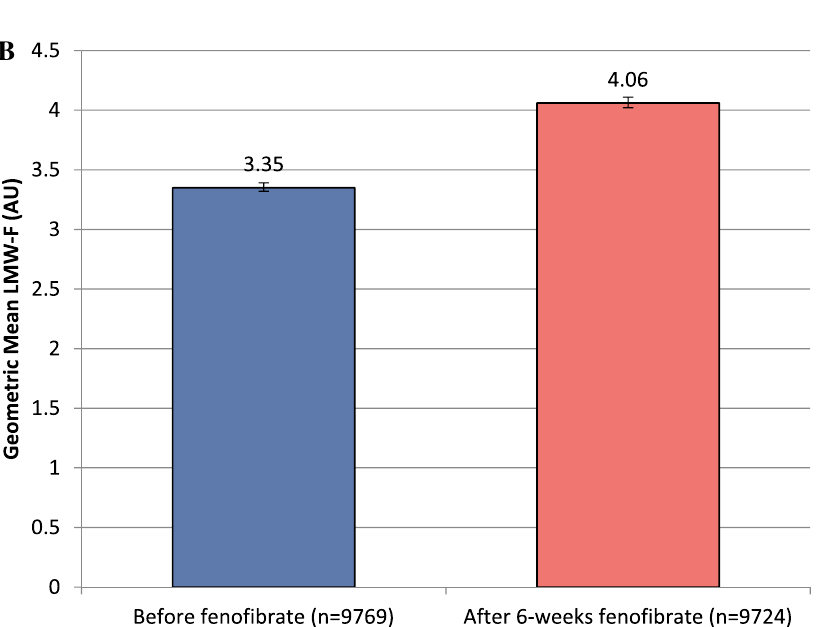
Figure 3. ( A ) Distribution of change in LMW-F between V1 and V4 16 weeks apart and after 6-weeks fenofibrate. ( B ) LMW-F levels before and after 6-weeks fenofibrate ( p < 0.001). ( C ) Changes in LMW-F levels over time and with fenofibrate in participants with LMW-F measurements at V7. All participants received fenofibrate from V1 to V4 (for the last 6 weeks), before being subsequently randomised to 5 years of fenofibrate or placebo. Error bars show 95%